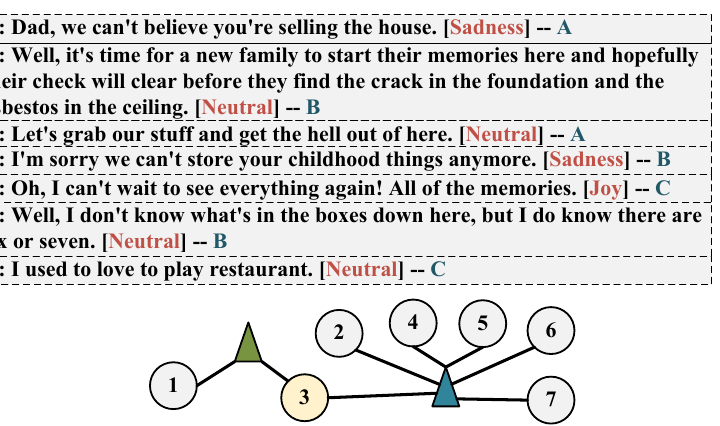
Figure 1. Conversation as a hypergraph. Circles and triangles represent nodes and hyperedges, respectively. A. B, C are participants in the